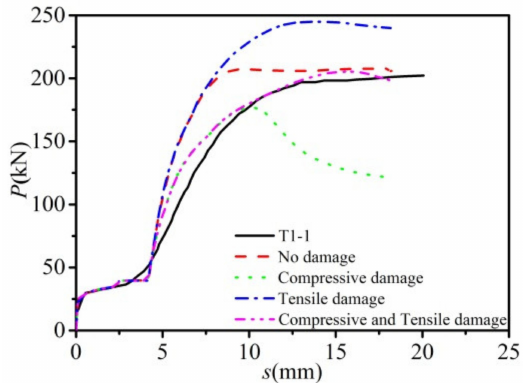
Figure 9. Effect of damage variables on load-slip relationship of T1-1